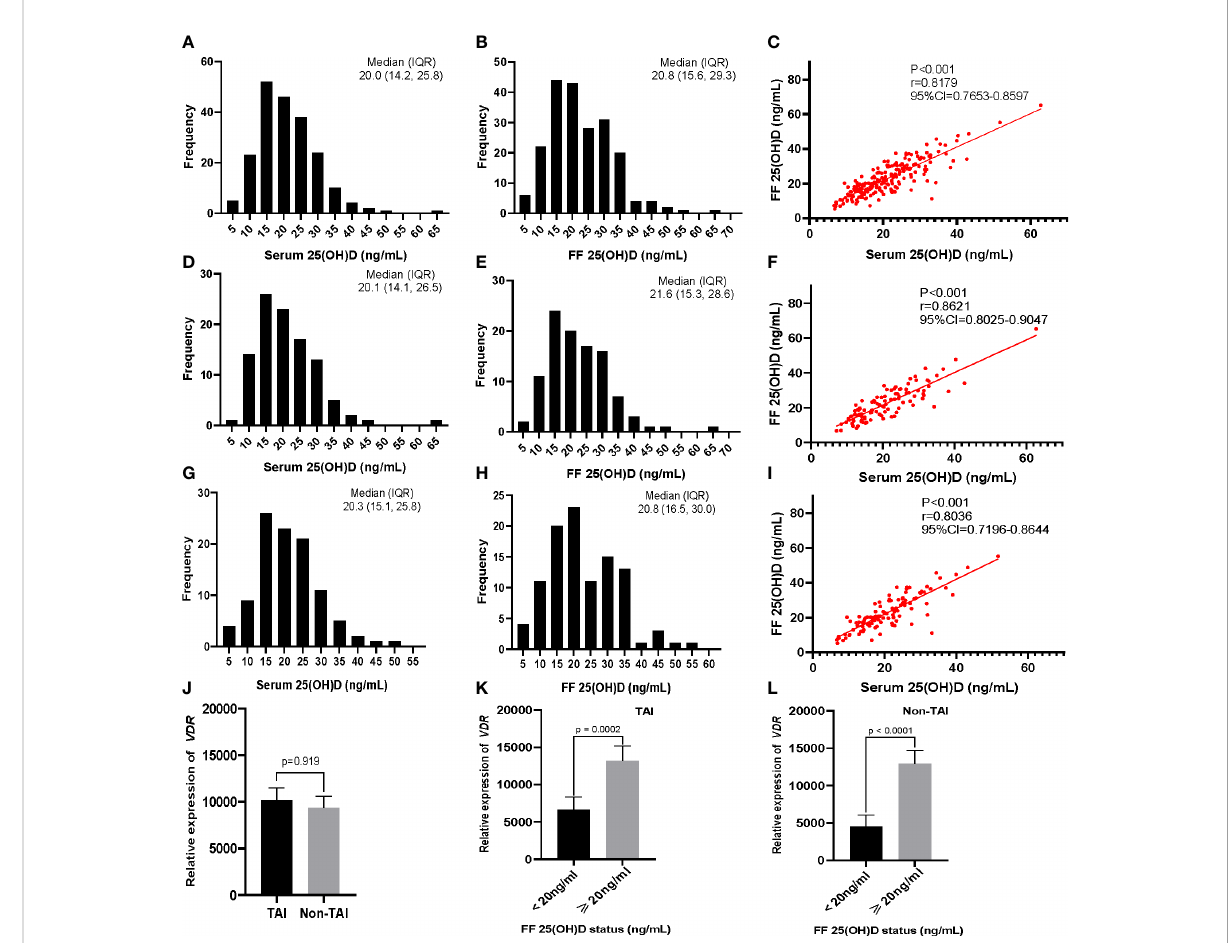
FIGURE 1 Distribution and correlation of serum and follicular fl uid (FF) 25(OH)D concentrations in participants, and vitamin D receptor ( VDR ) gene expression in patient granulosa cells determined using RT-PCR. Distribution of (A) serum and (B) FF levels of 25(OH) D in all 206 participants. (C) Correlation of serum and FF levels of 25(OH)D. (D – F) Corresponding distribution and correlation results for the TAI (n = 103) and (G – I) non- TAI groups (n = 103). (J) VDR expression in the TAI and non-TAI groups. (K, L) Level of VDR expression based on the FF 25(OH) D status (<20 ng/mL and ≥ 20 ng/mL) for (K) TAI and (L) non-TAI patients. The correlations between serum and FF 25(OH)D levels were determined using Spearman rank correlation analysis. The Mann – Whitney U test was used to compare the relative expression of VDR in different groups. Data are presented as the mean ±